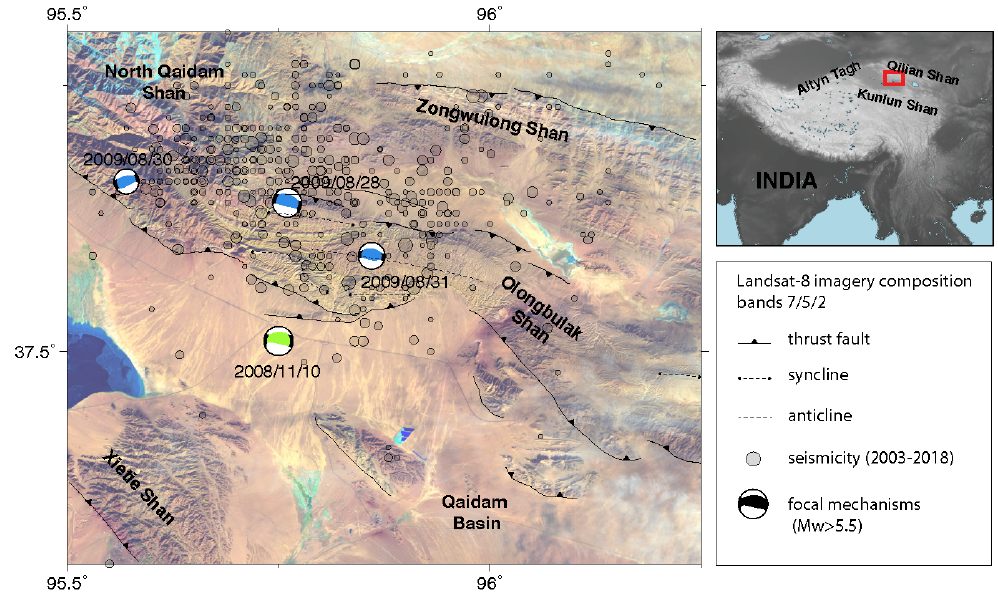
Figure 1. Seismotectonic setting of the Olongbulak ranges in the northeastern part of the Tibetan Plateau superimposed on a false colour Landsat 8 satellite image (U.S. Geological Survey, https://earthexplorer.usgs.gov/). The uplifted Paleogene, Cretaceous and Jurassic deposits form a distinctive yellow band within the Olongbulak pop-up, between dark Jurassic to Cambrian bedrock. Mapped faults from our own analysis are shown as black lines. The locations and focal mechanisms of the three M w > 5.2 earthquakes of the 2008–2009 Qaidam sequence are shown with their mechanisms as lower-hemisphere stereo-projections [64] (2008 and 2009 in green and blue, respectively). Grey transparent circles show the historical seismicity from 2003 to 2018 from the U.S. Geological Survey catalogue (M > 4.0) and a regional Chinese catalogue (M > 2.0,